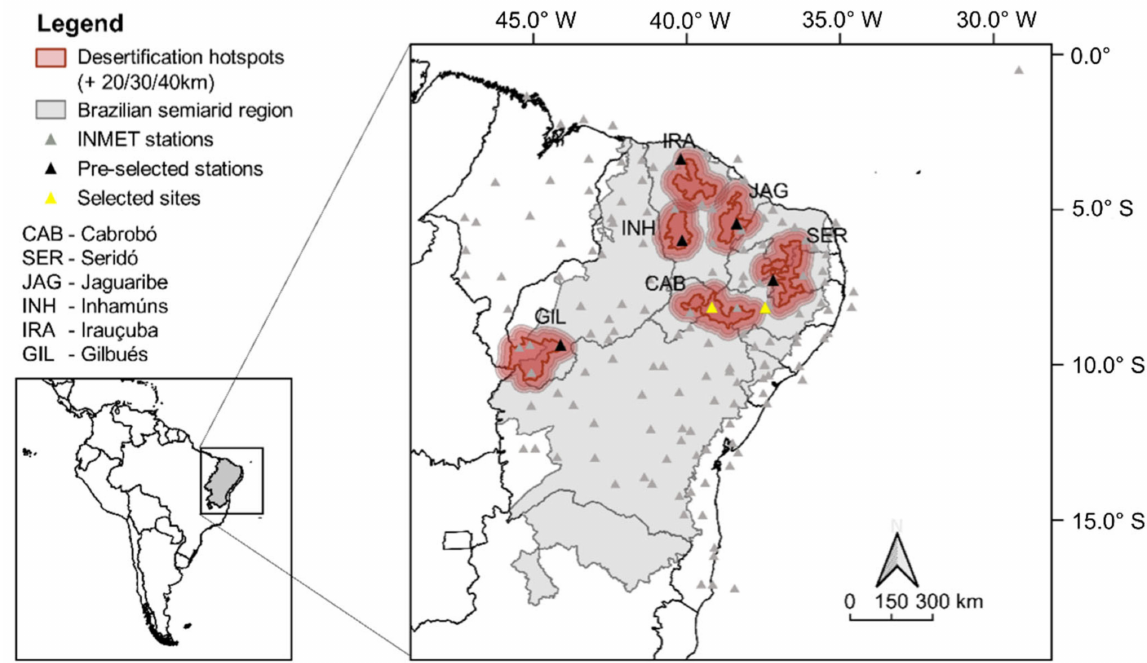
Figure 1. Spatial distribution of INMET stations and location of desertification